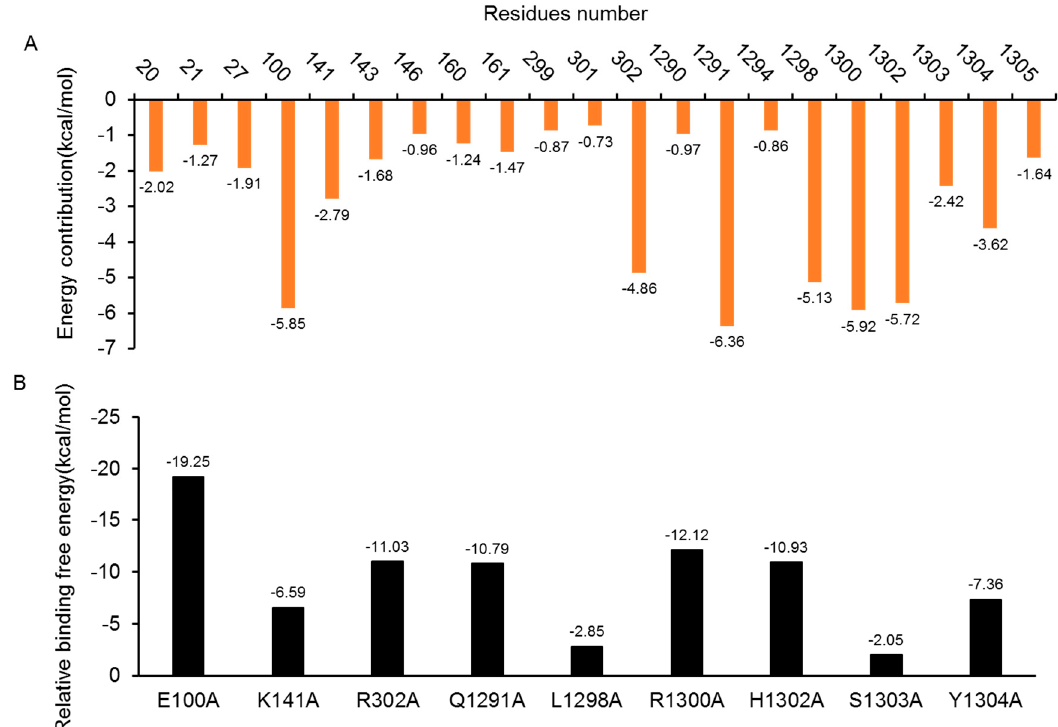
Figure 6. ( A ) Per-residue binding energy decomposition of predicted GluN2B-CT 1290–1310 /DAPK1 complex 1 . The energy contribution (the absolute value) larger than 0.60 kcal/mol to at least one of the studied residues for the binding of GluN2B-CT 1290–1310 /DAPK1 are displayed. The orange bar shows the residues with an absolute binding free energy value of more than 0.60 kcal/mol. ( B ) Alanine scanning analyses of predicted GluN2B-CT 1290–1310 /DAPK1 complex 1 .